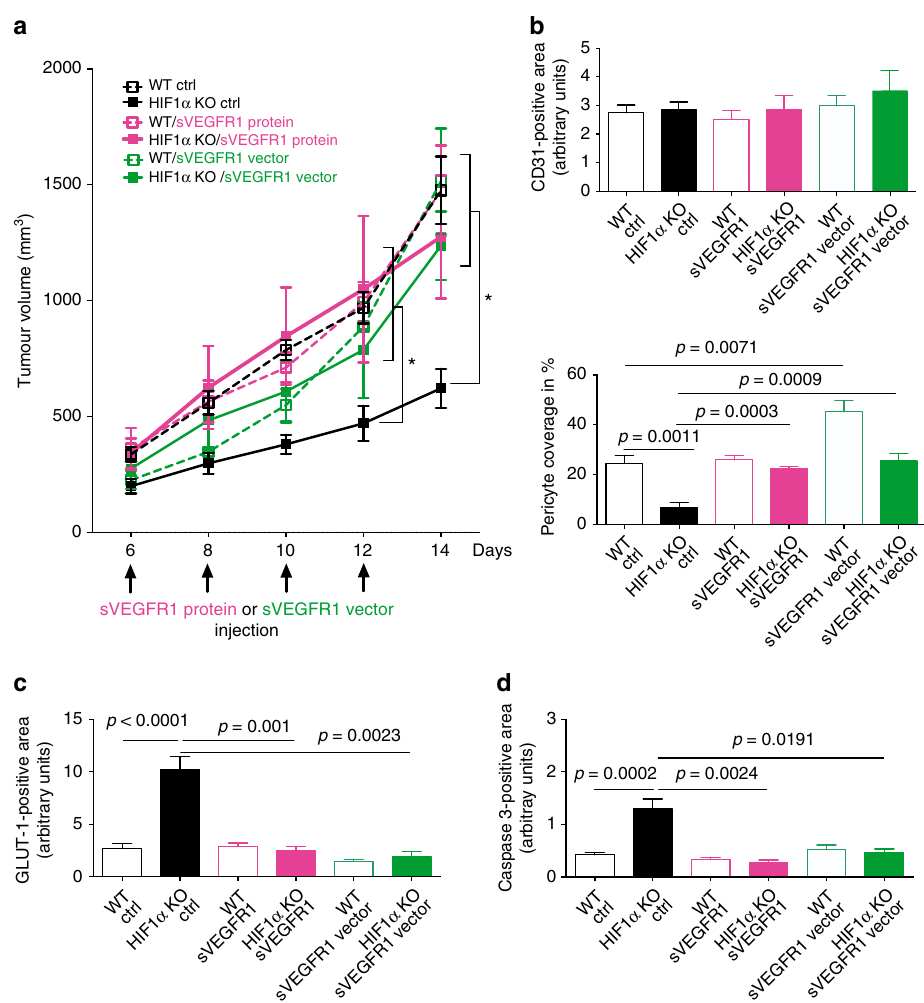
Fig. 4 Reconstitution of sVEGFR1 rescues the HIF-1 α KO phenotype. a Tumour volume analysis of MC38 isografts implanted in WT and HIF-1 α KO mice after intratumoural injection with recombinant sVEGFR1 protein or sVEGFR1 vector at day 4, 6, 8, and 12 at endpoint, day 14. Control mice received intratumoural injections of 100 μ l PBS or ctrl vector. b Quantitative analysis of CD31-positive endothelial cells and pericyte coverage as assessed by α - SMA/CD31 co-localisation at endpoint, day 14. c Quantitative analysis of hypoxic tumour areas with the speci fi c marker GLUT1 at endpoint, day 14. d Quantitative analysis of caspase-3-positive areas at endpoint, day 14 ( n = 10 for ctrl group; n = 5 for sVEGFR1 protein injection group; n = 3 for sFLT1 vector injection group). Statistical signi fi cance was determined by an unpaired Student ’ s t -test or one-way analysis of variance, where appropriate. Bars represent mean values; error bars indicate the s.e.m. Statistical signi fi cance is indicated as * P < 0.05, ** P < 0.01, and *** P <